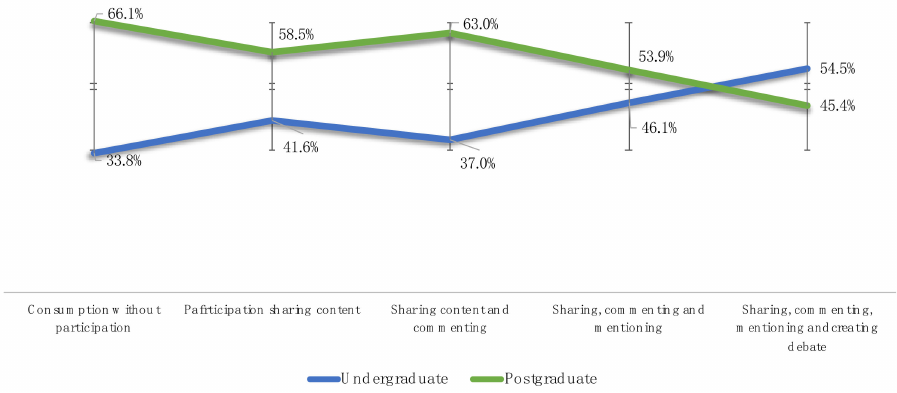
Figure 2. Level of engagement in social networks in